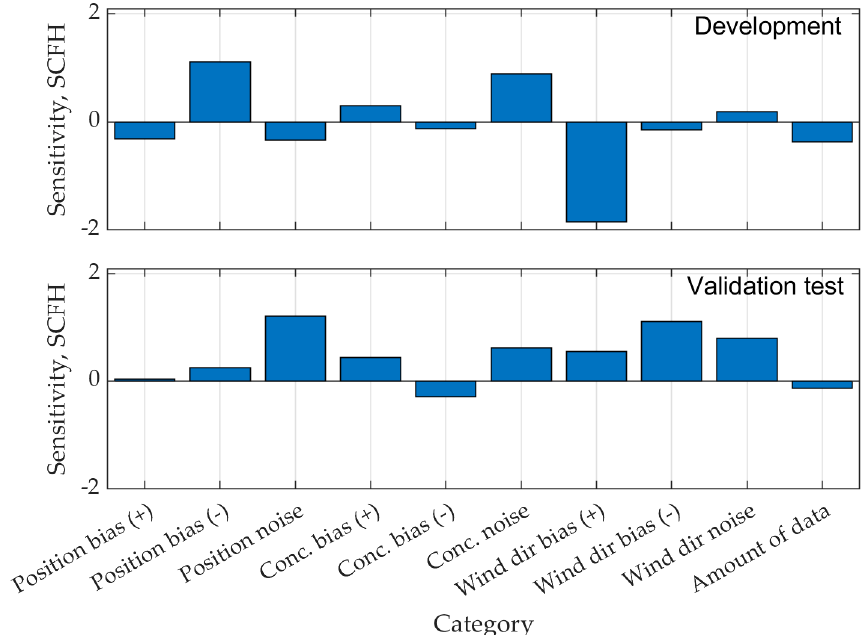
Figure 12. Sensitivity analyses for the rotated flux leak rate method. The same assumptions were applied as in Figure 11. Atmosphere 2018 , 9, x FOR PEER REVIEW